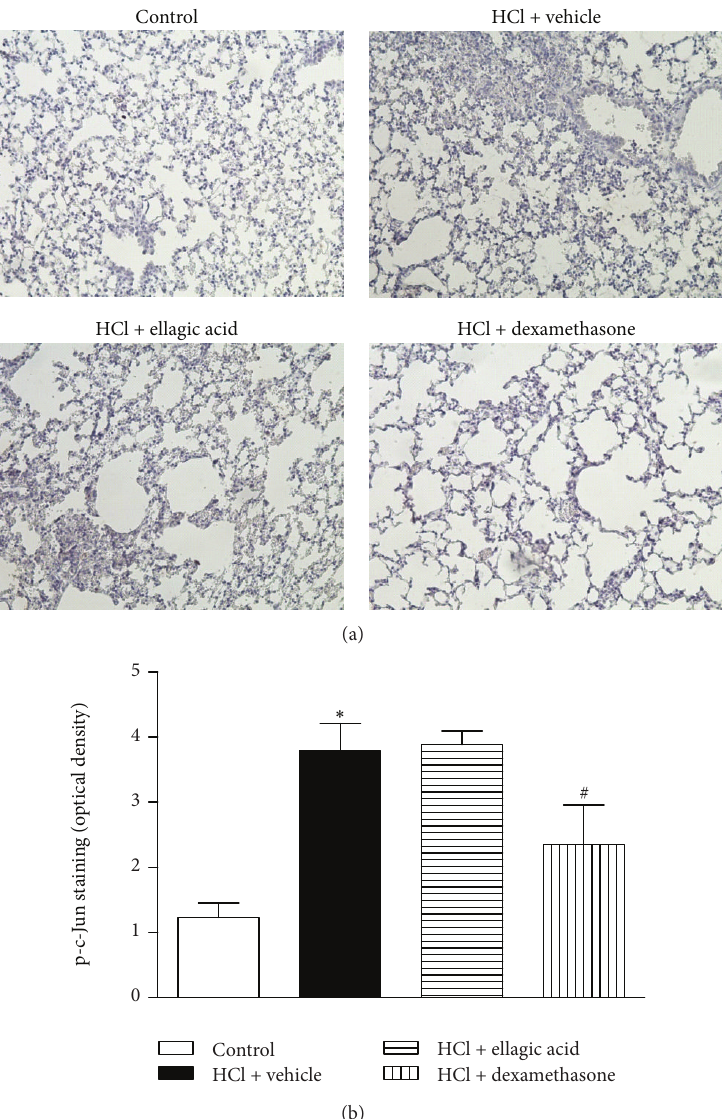
Figure 5: Effect of therapeutic treatment with ellagic acid on the activation of phospho-c-Jun AP-1. Representative images of phospho- c-Jun AP-1 immunohistochemistry staining of control, HCl + vehicle group, HCl + ellagic acid group, and HCl + dexamethasone group (magnification: × 200) (a). The mean intensity of phospho-c-Jun AP-1 staining was determined from image analysis and represented as arbitrary units (b). The analyses of lung were carried out in the peak of inflammation (12h). Values represent the mean ± SEM ( 𝑛 = 4 per group) for immunohistochemical analysis. ∗ 𝑃 < 0.05 compared with control group; # 𝑃 < 0.05 compared with HCl + vehicle